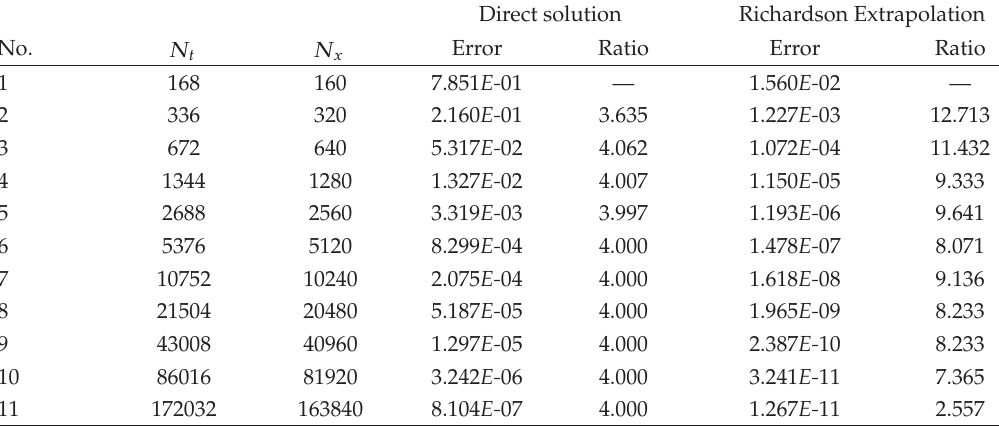
Table 2: Results obtained when the test problem defined by (cid:6) 5.7 (cid:7) – (cid:6) 5.9 (cid:7) is handled directly by the Crank- Nicolson scheme and by using the combination of the Crank-Nicolson scheme and the Richardson Extrapolation. The numerical errors calculated by (cid:6) 5.1 (cid:7) and (cid:6) 5.2 (cid:7) are given in the columns under “Error”. In row s, s (cid:3) 2 , 3 ,..., 11, the ratios of the errors in this row and in the previous row are given in the columns under